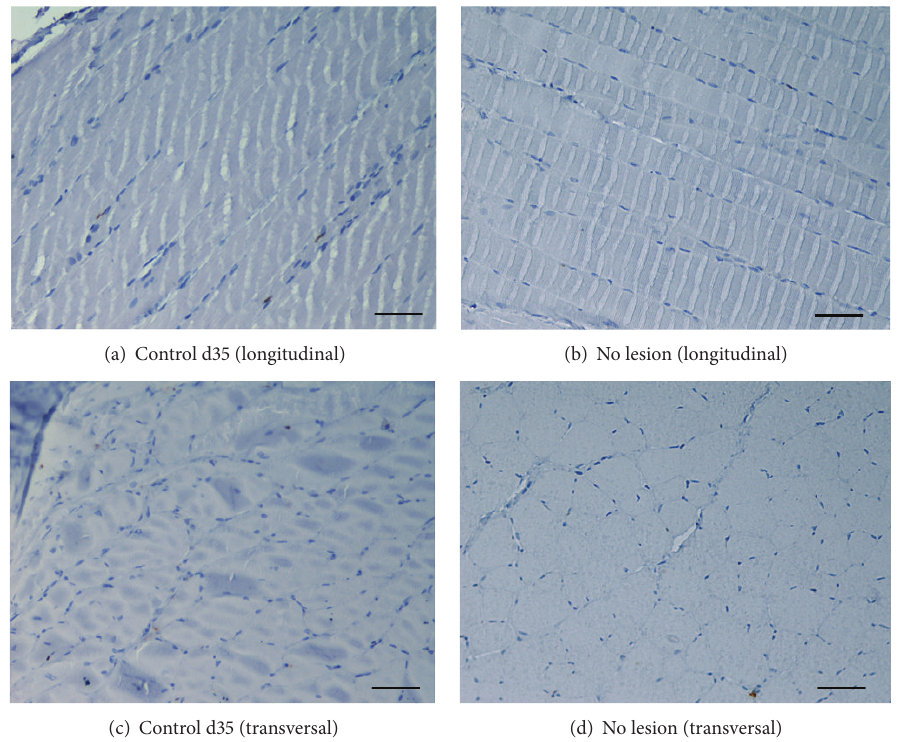
Figure 8: IHC sections from tibialis anterior (TA) muscles: the presence of Pax7 + nuclei in the Control (a and c) group (evaluated at d35 postmyectomy) was similar to the noninjured TA muscles (b and d) (magnification: 200x). Scale bar: 50 𝜇